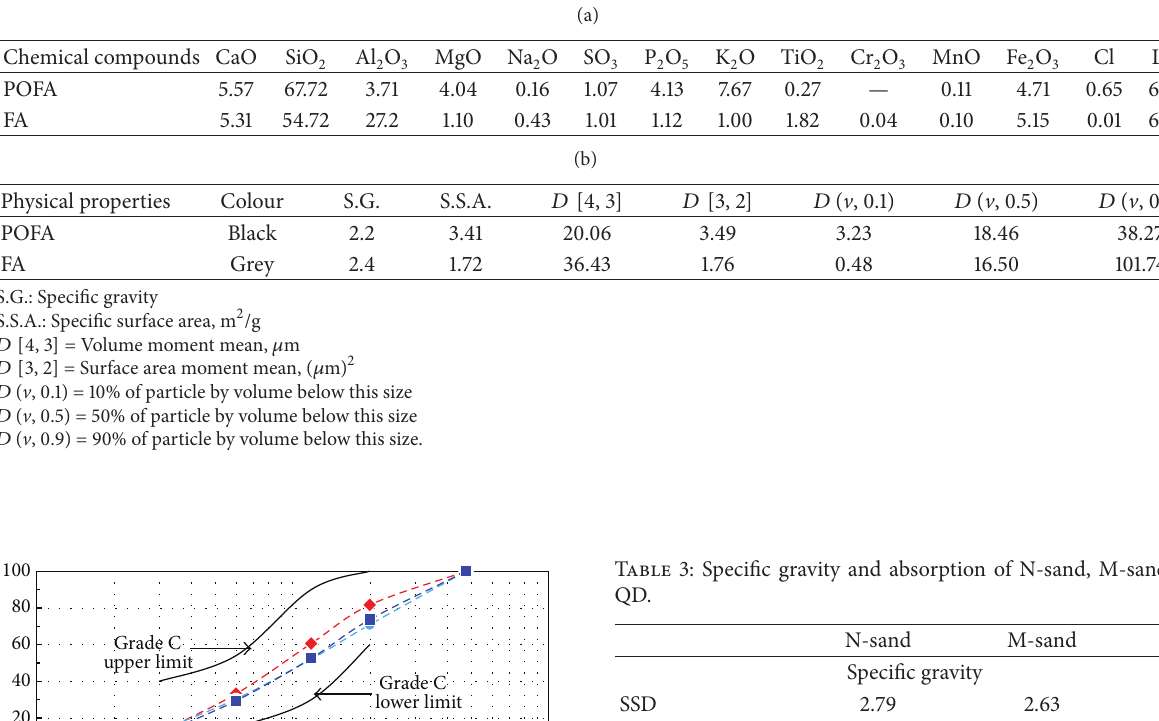
Table 1: Chemical composition and physical properties of POFA and FA.